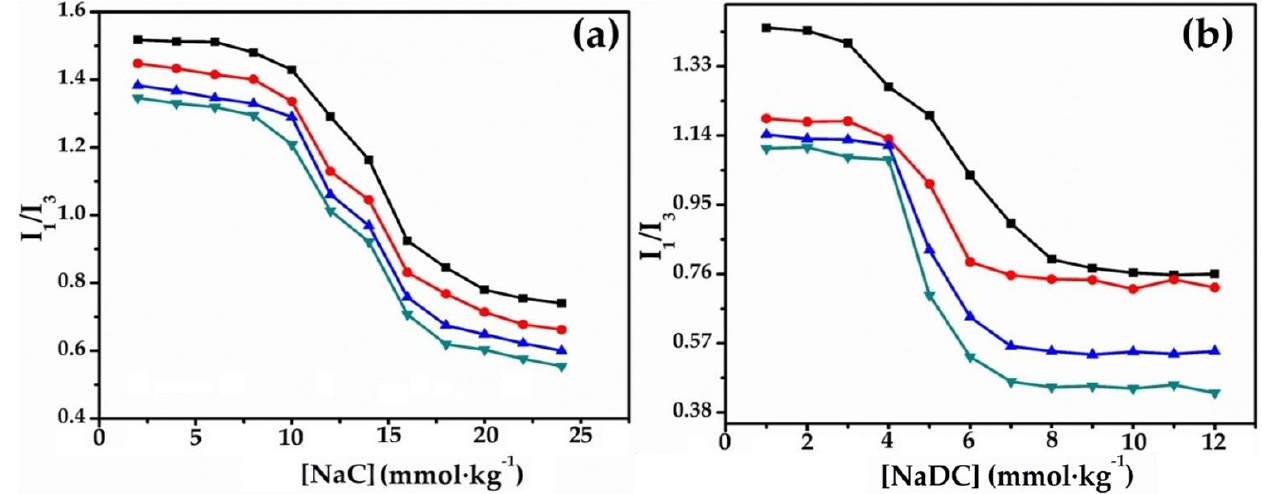
Figure 6. Plots of I 1 /I 3 versus concentration of ( a ) NaC and ( b ) NaDC in pure water and in 0.001 ( ■ ), 0.005 ( ● ), and 0.010 ( ▲ ) mol∙kg -1 glycyl dipeptide.